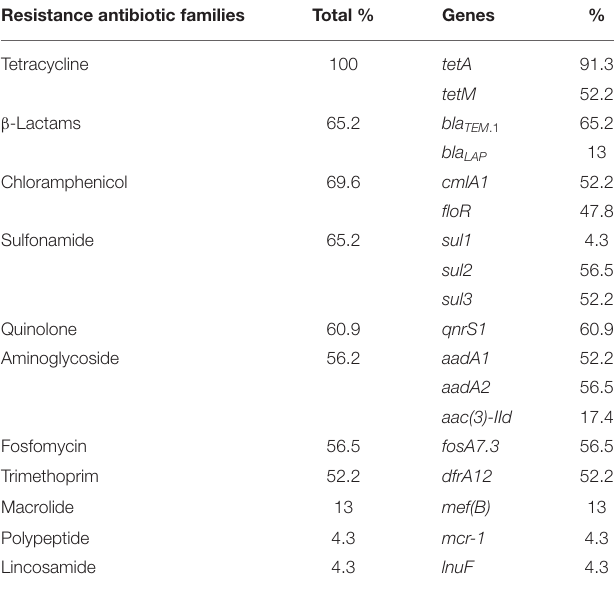
TABLE 3 | Resistance genes of the 23 isolates of Salmonella enterica subsp. enterica serovar Derby and Rissen. Resistance antibiotic